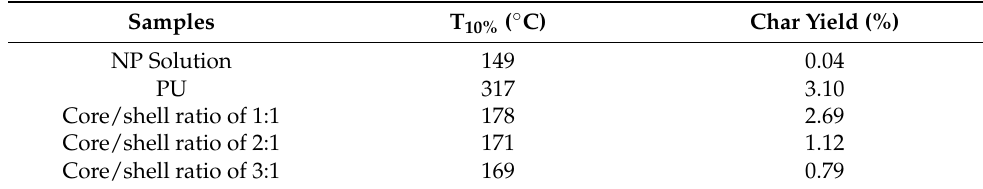
Table 1. Results of the thermogravimetric analysis of PU, NP solution, and microcapsules with core/shell ratio of 1:1, 2:1 and